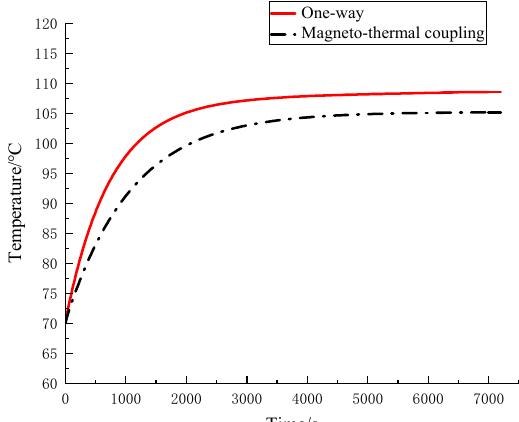
Figure 7. Magneto-thermal coupling time–temperature curve.